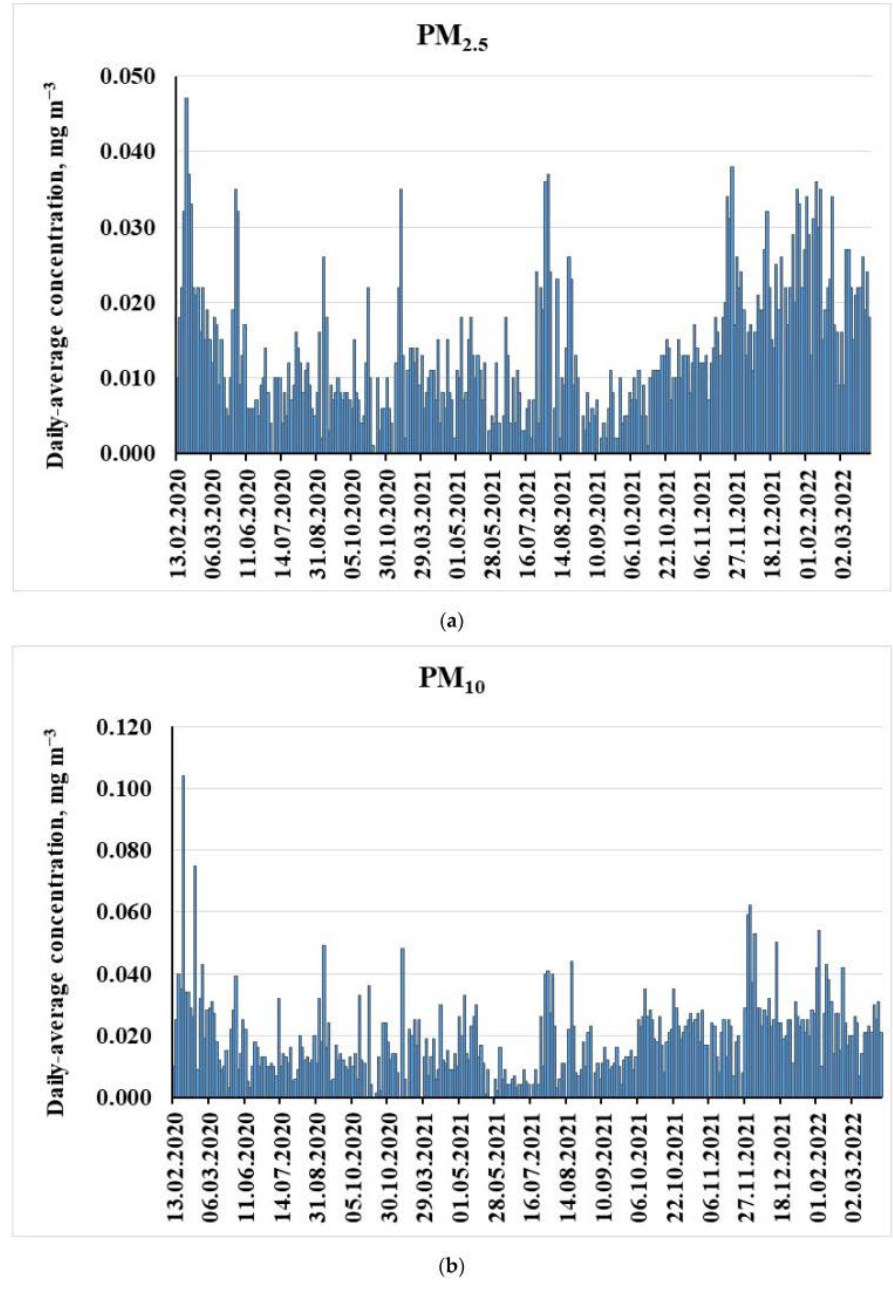
Figure 3. Time series plots of PM 2.5 ( a ) and PM 10 ( b ) concentrations in the atmospheric air in